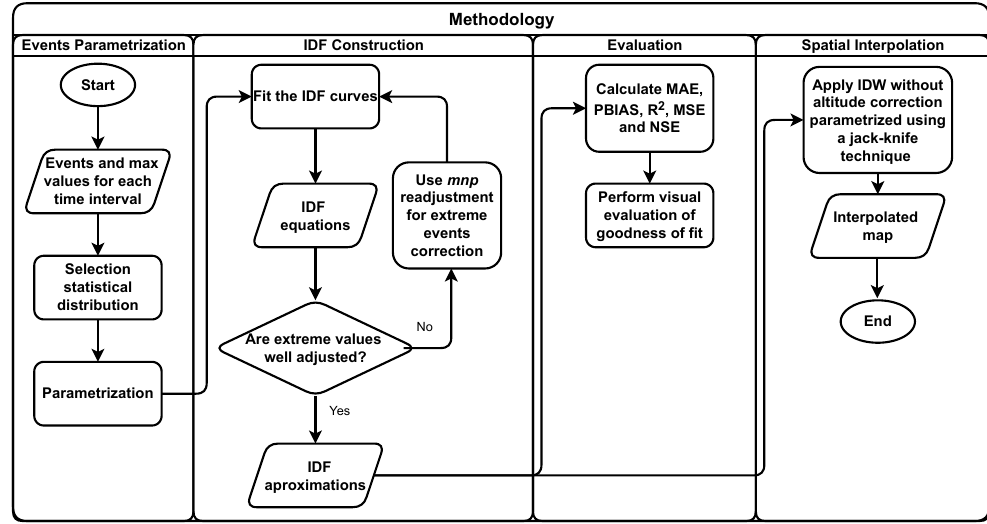
Figure 4. General overview of the